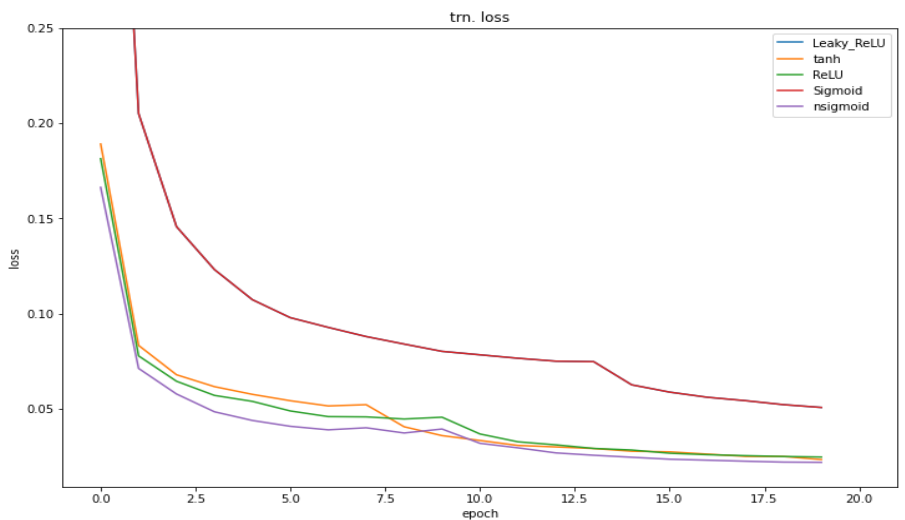
Figure 7. Comparison of the training loss of the convolutional neural network (CNN) training for all the activation functions. Table 2. Effects of other activation functions on the SE structure using